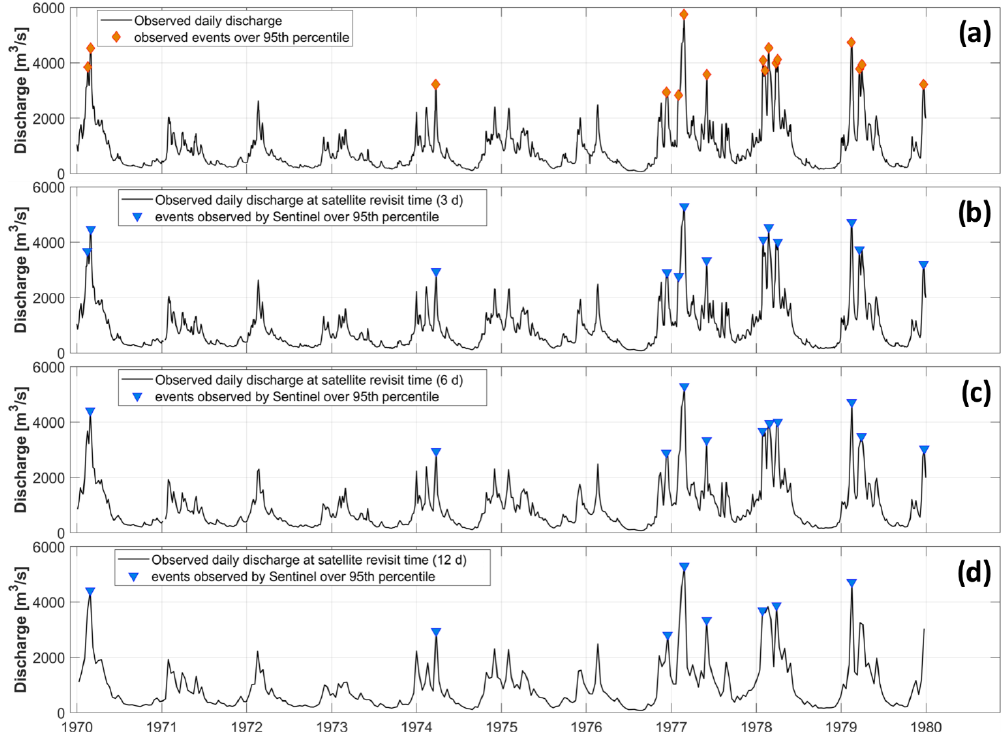
Figure 3. Example of event selection by ground-observed daily discharge (a) and assuming satellite revisit times of 3d (b) , 6d (c) and 12d (d) for the Loire River at Mont Jean gauge